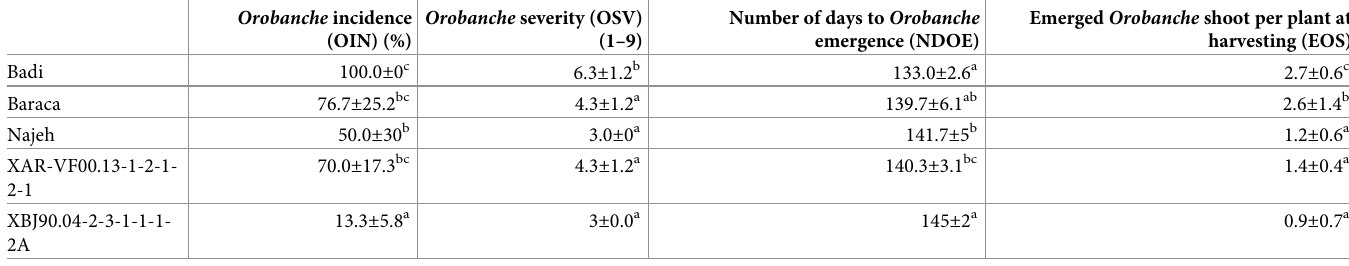
Table 3. Orobanche incidence (%) and Orobanche severity (1–9), Number of Days to Orobanche Emergence (NDOE) and number of Emerged Orobanche Shoots per plant (EOS) recorded for different studied genotypes in high O . foetida infested field during the cropping season 2010/2011.